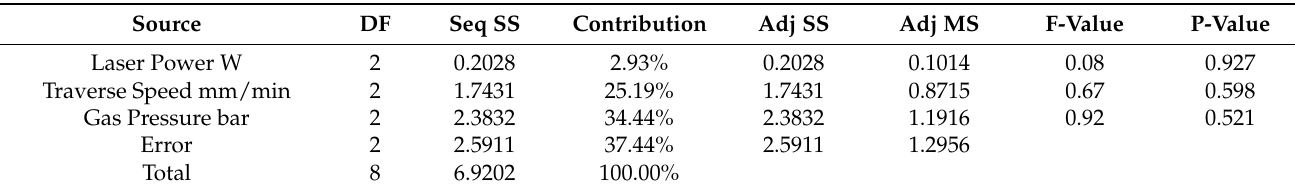
Table 9. ANOVA table for kerf taper angle response of input cutting parameters of 2 mm thickness of SPF-UPE composite cut by laser beam cutting process.